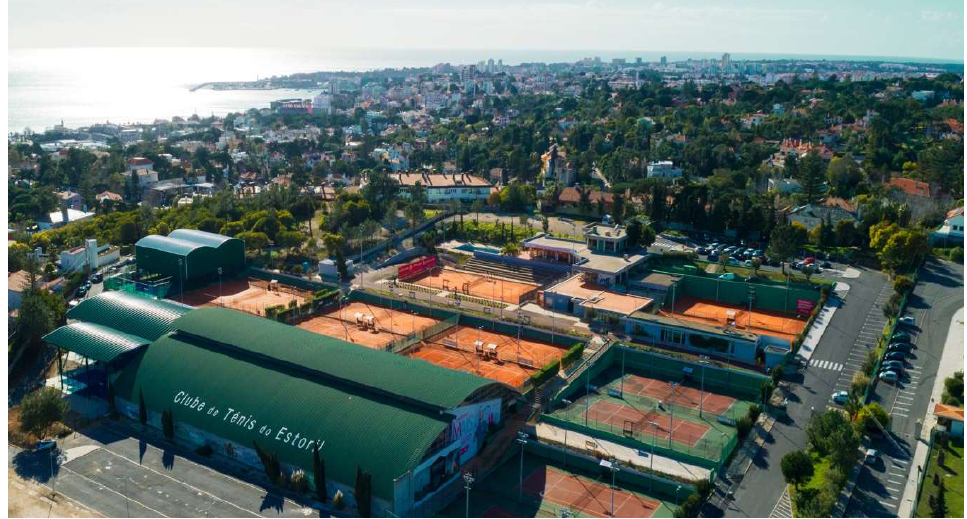
Figure 1. Aerial view of the Estoril Tennis Club (ETC).